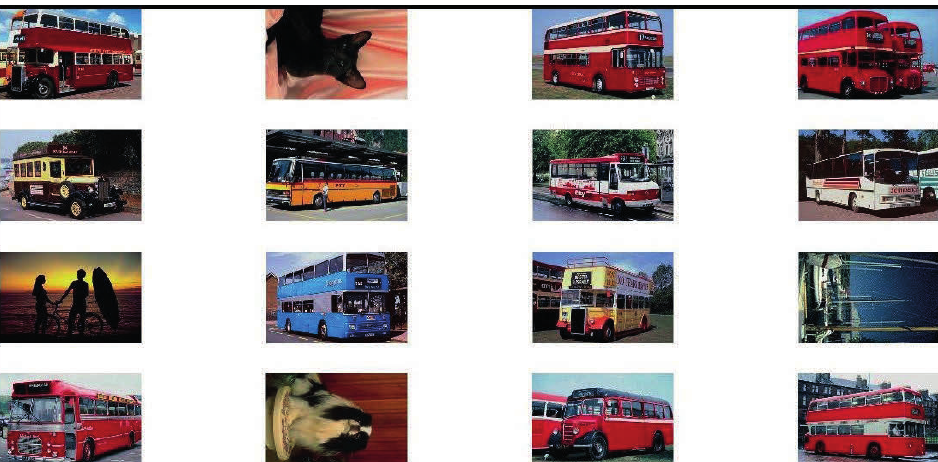
Fig. 20. Bus images retrieved using Framework-1 (EHD-KM).